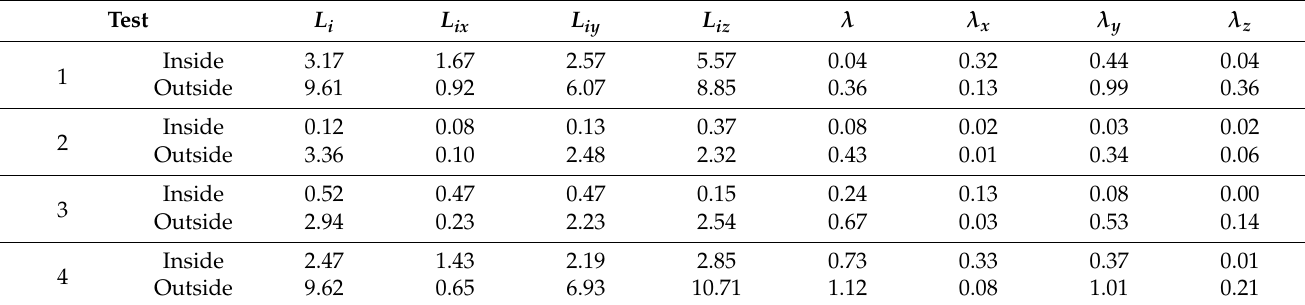
Table 5. Macroscale L i [m] and microscale λ [m] (longitudinal component, L ix ; transversal component, L iy ; vertical component, L iz